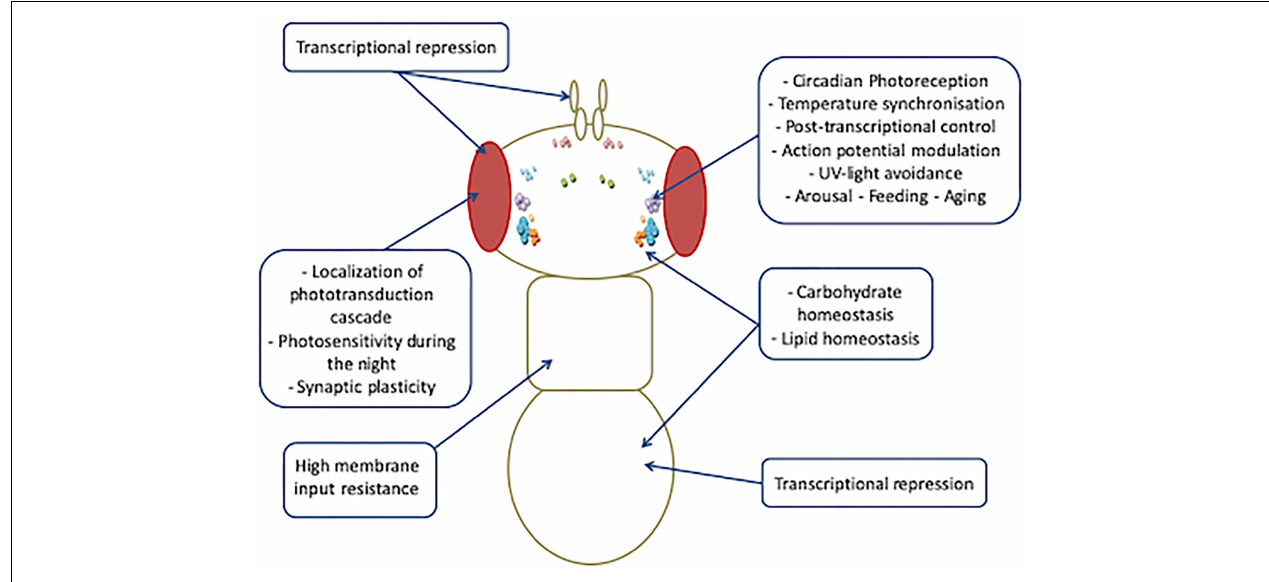
FIGURE 5 | Overview of tissue-specific activities of